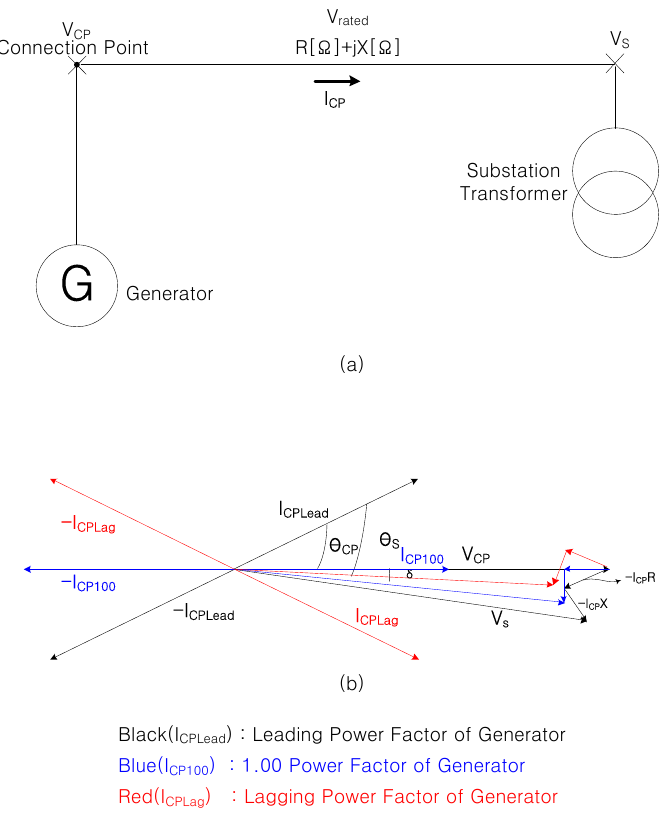
Figure 1. Grid-connected renewable energy generators (REGs): ( a ) Single line diagram; ( b ) vector diagram. 𝑉 𝑅𝑎𝑡𝑒𝑑 : Rated voltage of DL (V); 𝑉⃗ 𝐶𝑃 : Connection point voltage (V); 𝐼 𝐶𝑃 : Connection point current (A); DL: Distribution line; 𝑉⃗ 𝑆 : Station voltage (V)